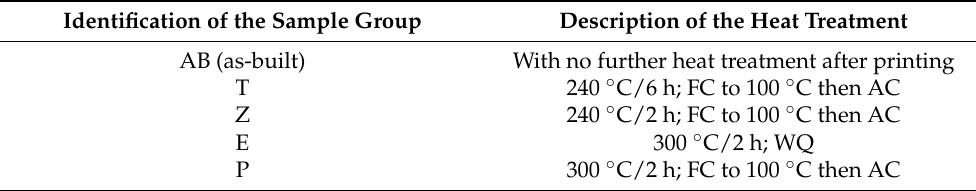
All samples were machined at Slovtos S 280 CNC to the precise shape for the